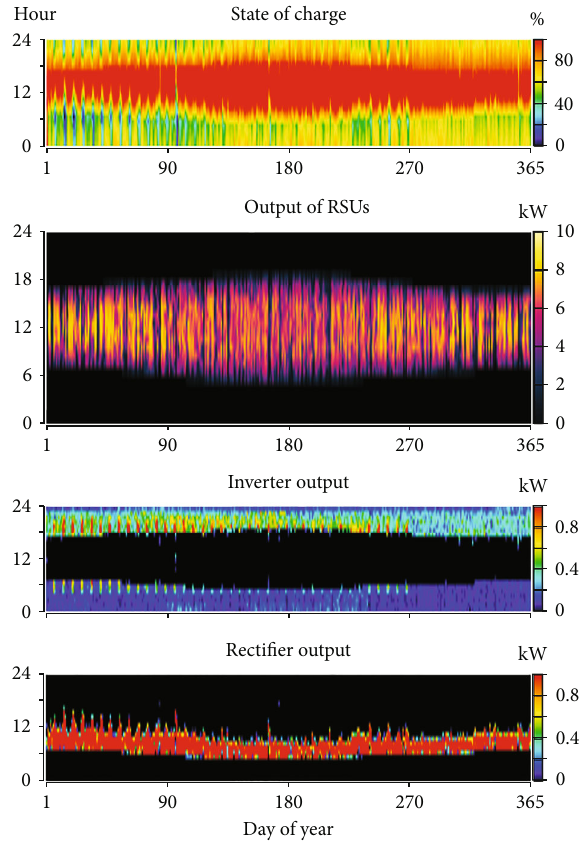
Figure 6: State of charge of the battery, power output of RSUs and system converter (including inverter output and recti fi er